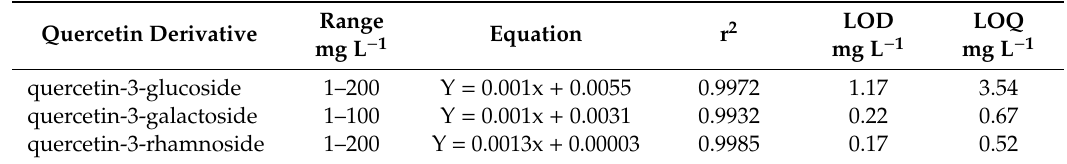
Table 1. Linearity, limit of detection (LOD), limit of quantification (LOQ) of Folin-Ciocalteu spectrophotometric method for the determination of quercetin derivatives.